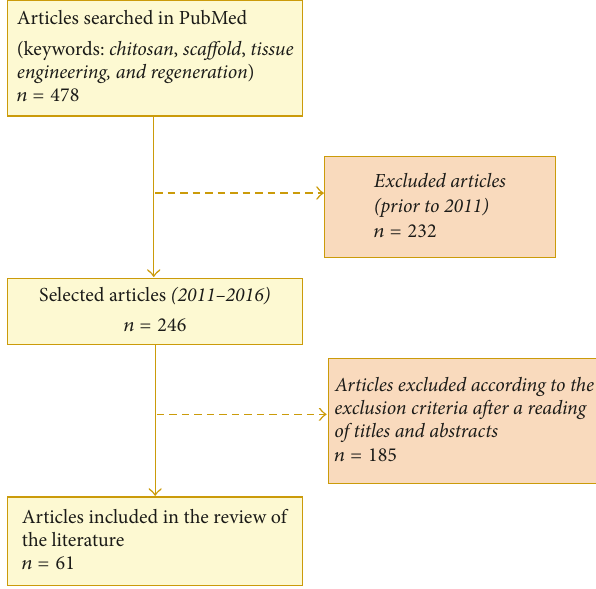
Figure 3: Flowchart of the research study and selection of articles for bibliographical